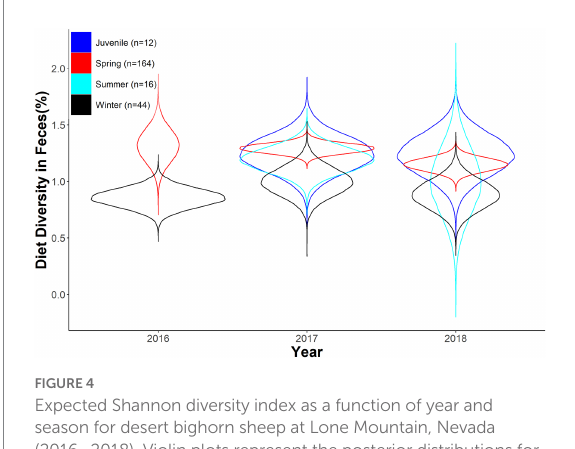
FIGURE 4 Expected Shannon diversity index as a function of year and season for desert bighorn sheep at Lone Mountain, Nevada (2016–2018). Violin plots represent the posterior distributions for predicted mean values derived from an ANOVA model of Shannon diversity index modeled as a function of year and season (with interaction term), which was fitted in a Bayesian framework ( n = 10).